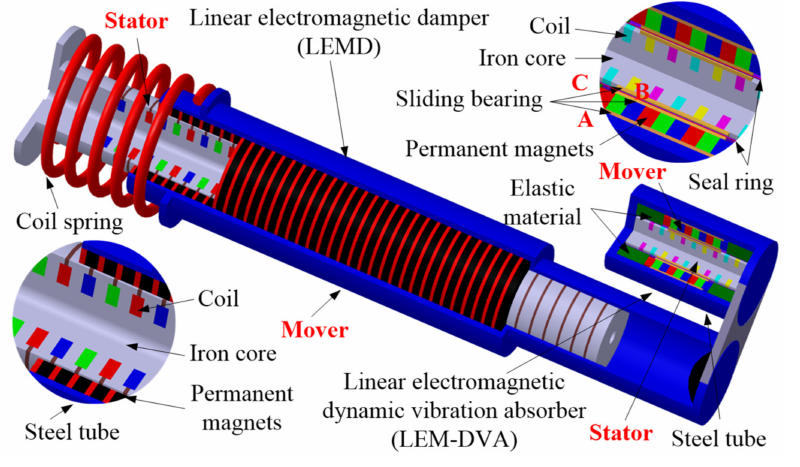
Figure 13. Schematic of the new